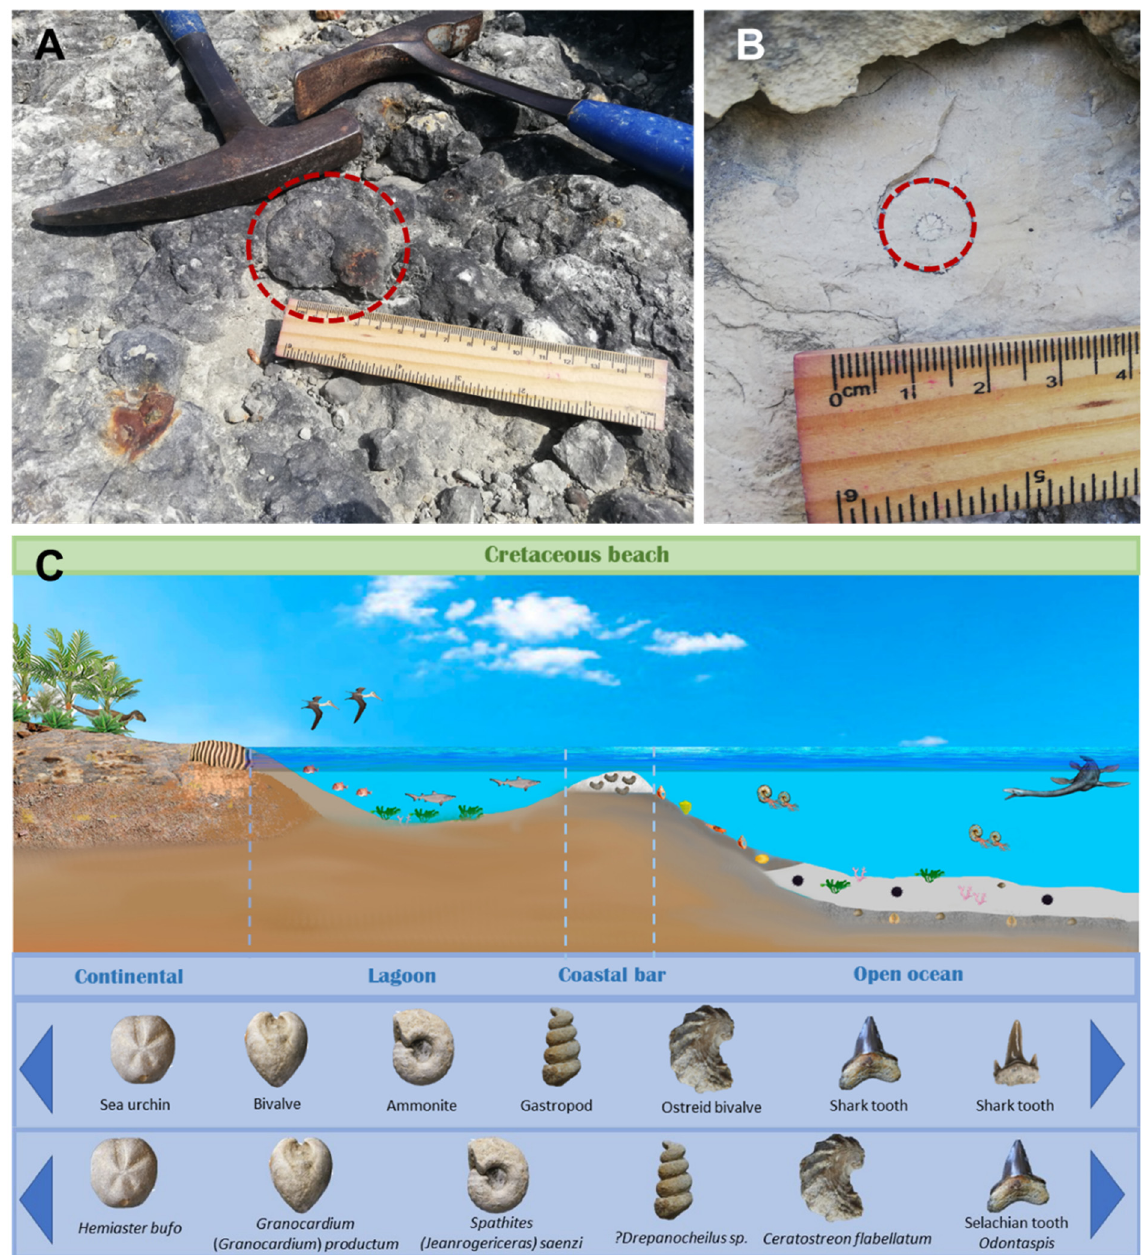
Figure 7. Sample of didactic activities. ( A ) Photograph of an in situ ammonite (red dashed circle) at the Figueira da Foz Site (Portugal) for the activity “The Fossil Hunt” (Appendix A). ( B ) Photograph of an in situ coral fragment (red dashed circle) at the Figueira da Foz site (Portugal) for the same activity. ( C ) Image of the online/virtual activity “Cretaceous beach” (Appendix B), showing two levels of difficulty regarding the name of the specimen.